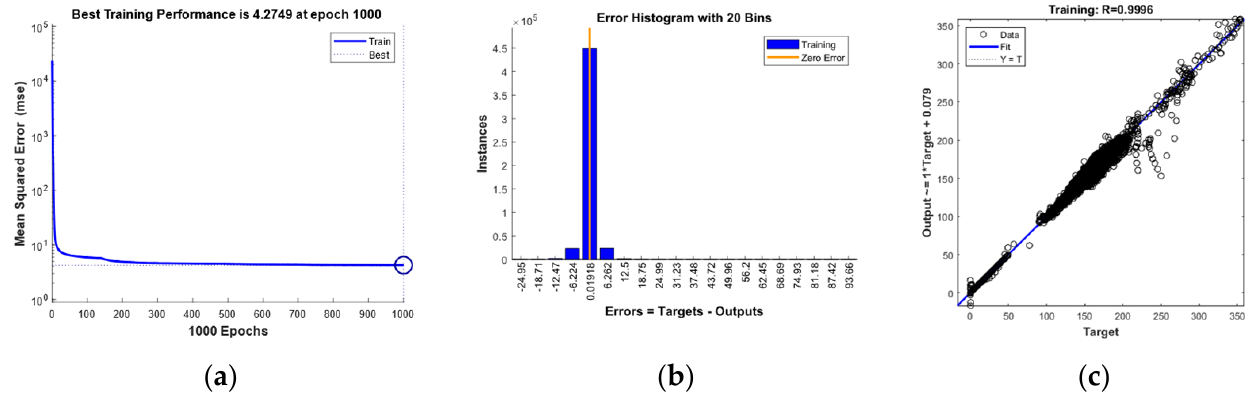
Figure 21. ( a ) Performance of the ANN-based electromagnetic torque M e estimator considering mean squared error (MSE); ( b ) Error histogram of electromagnetic torque M e ; ( c ) Regression between the electromagnetic M e torque estimated by the ff ANN and the measured one in the IM drive.